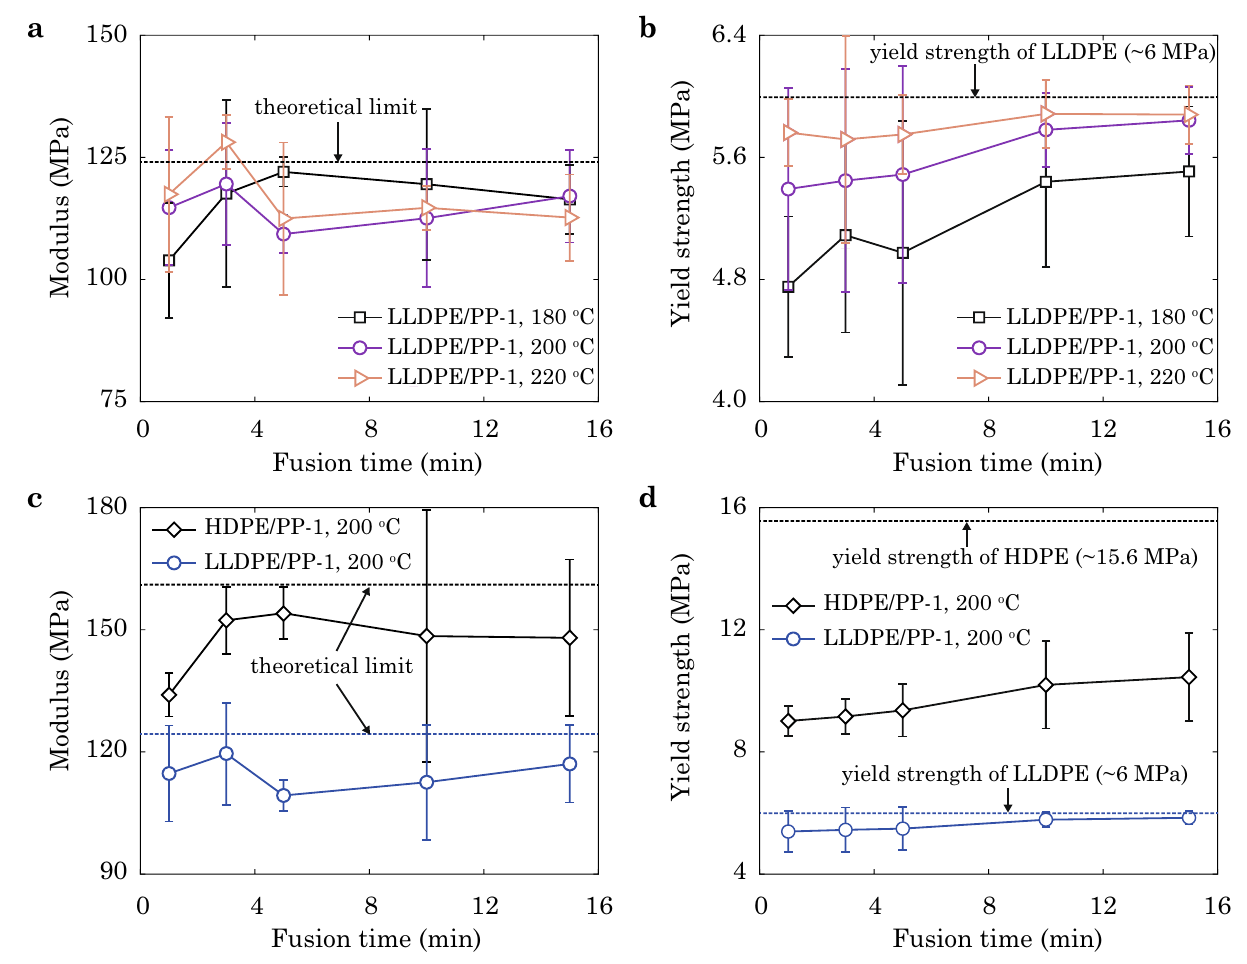
Figure 7. ( a ) Experimental results for the Young’s modulus and ( b ) yield strength of LLDPE/PP-1 samples obtained at T = 180, 200, 220 ◦ C in HCM. ( c , d ) Experimental results for LLDPE/PP-1 and HDPE/PP-1 samples obtained at T = 200 ◦ C . Theoretical limits of moduli obtained from the rule of mixture and strengths of pure samples are plotted as dash